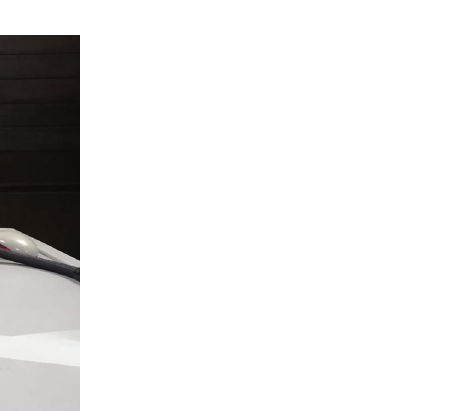
Figure 2. SEM representative images of exfoliated GNS ( a ) 1000 rpm, ( b ) 500 rpm and MoS2, ( c ) 1000 rpm, ( d ) 500 rpm.